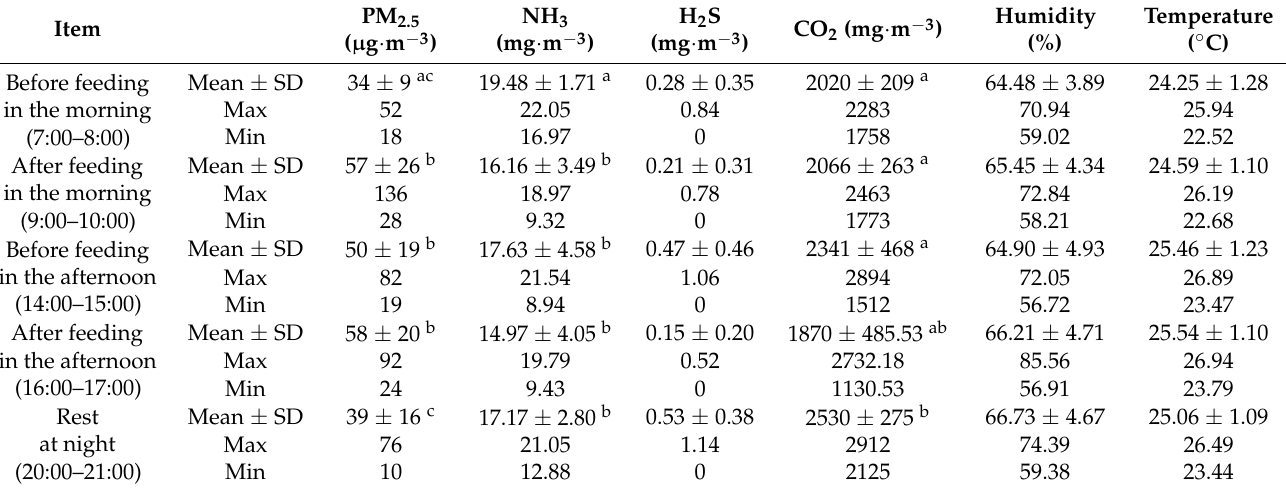
Table 1. Summary data from monitoring of the pig house at different time